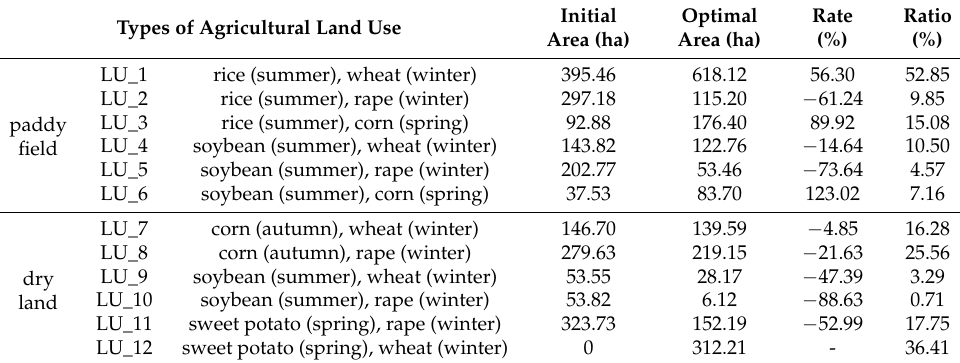
Table 4. Variation of each agricultural land type area following